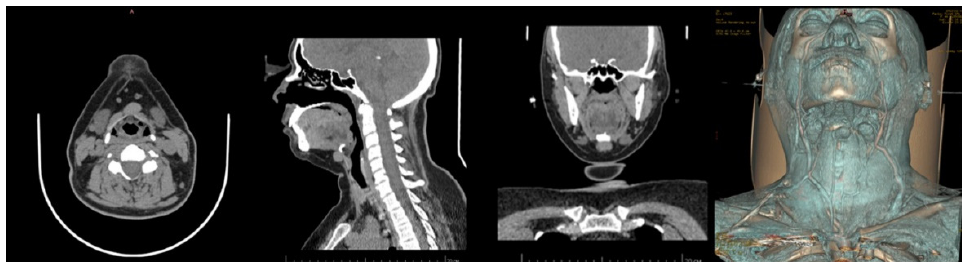
Figure 5. MSCT of the neck: axial view, lateral view, frontal view, and 3D reconstruction.